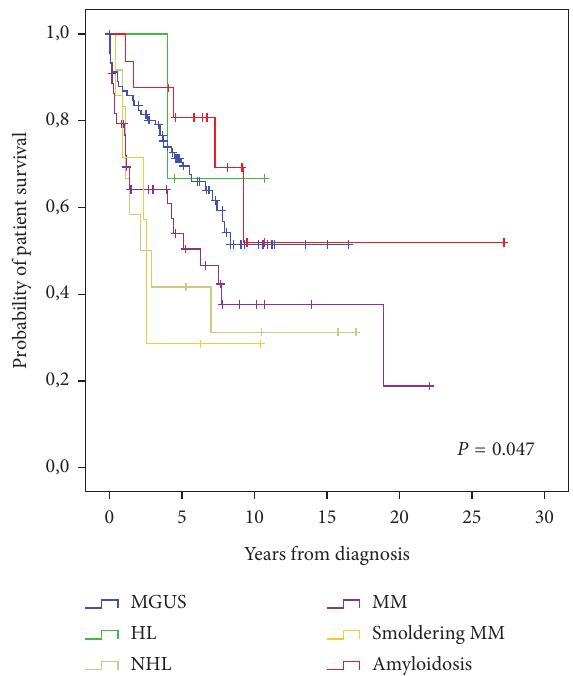
Figure 2: Overall survival according to the diagnosis of mono- clonal gammopathy.